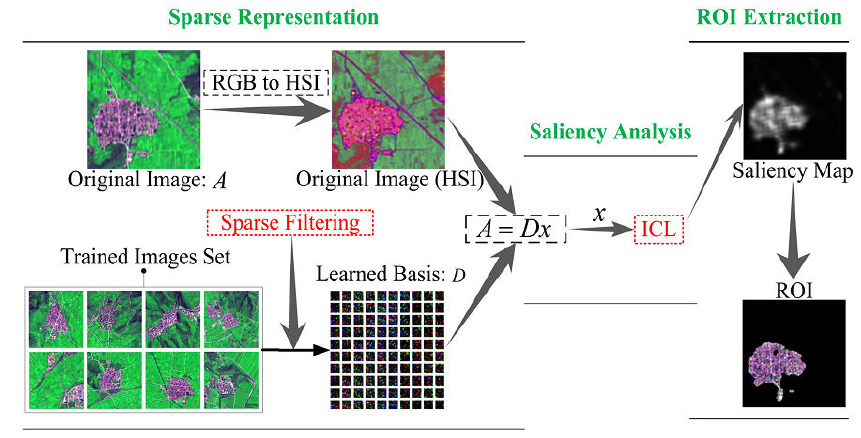
Figure 1. The framework of the proposed